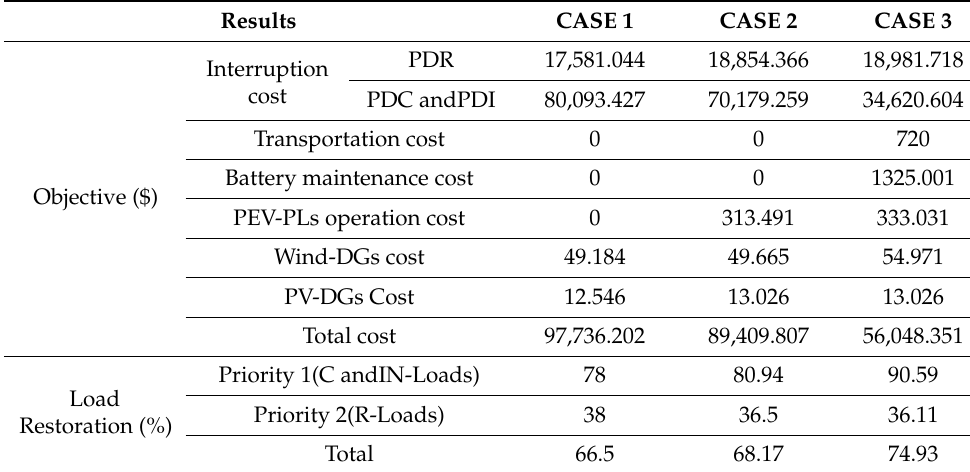
Table 5. Simulation results for distribution system